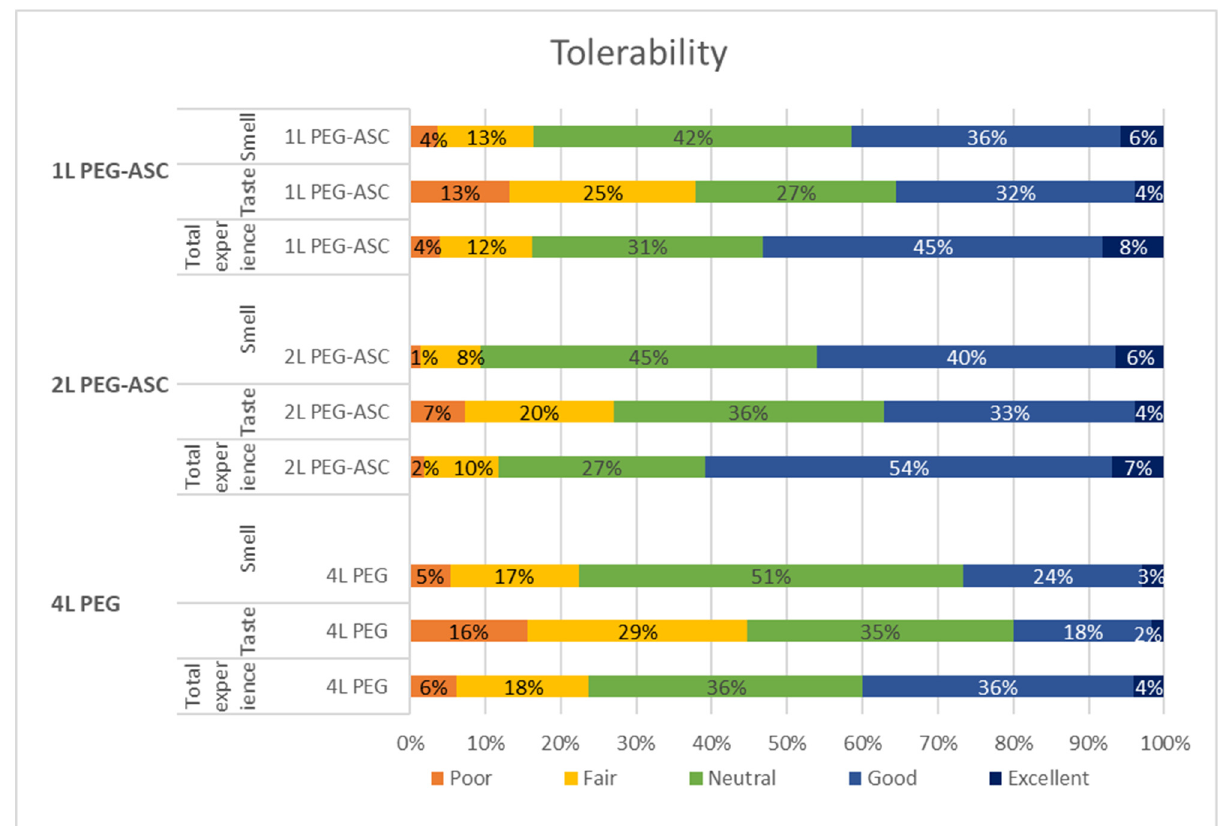
Figure 2. Stacked bar chart presenting proportions of answers for smell, taste, and total experience for the different laxatives studied, graded from poor to excellent. PEG, polyethylene glycol; PEG-ASC, polyethylene glycol + Ascorbate.